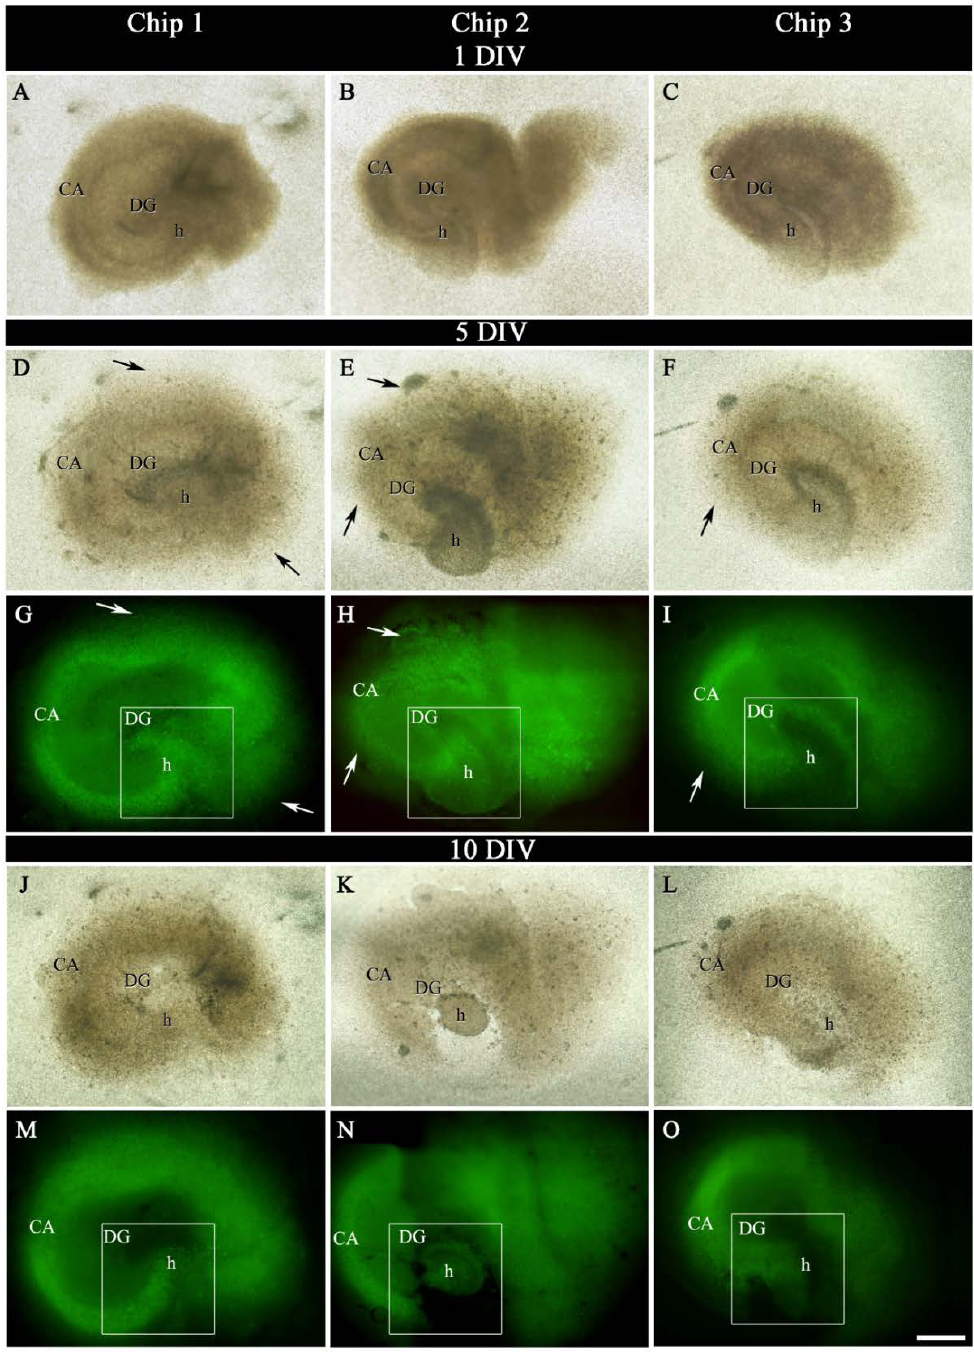
Figure 3. Septal sections of P7 mice hippocampal formation into brain slice-on-a-chip. Low-power photographs from slices placed into Chip 1 ( A , D , G , J , M ), Chip 2 ( B , E , H , K , N ), and Chip 3 ( C , F , I , L , O ) at 1, 5, and 10 DIV. ( A – F , J – L ) showed a progressive change in transparency of the tissue and shrinkage in section thickness from 1 DIV ( A , B , C ) to 5 DIV ( D , E , F ), that was more evident at 10 DIV ( J , K , L ). ( G – I , M – O ), low-magnification photomicrographs demonstrated similar distribution and intensity of OGB marker in the hippocampus section at 5 DIV ( G – I ) and 10 DIV ( M – O ) in all chips. The OGB marker showed two types of labeling (see also Figure 4) in chip sections along time: a dense dot-shaped labeling (early-medium phase) ( G , I ), and a sharp decrease labeling with partial or total lack of OGB labeled cells (late phase) ( M – O ) in some zones of the hippocampal subfields. ( D – I ) presented a better preservation of the hippocampal cytoarchitecture at 5 DIV compared to 10 DIV. Note, that in ( N ) there was a dramatic reduction of DG size. Solid-arrows display outgrowth of cells from